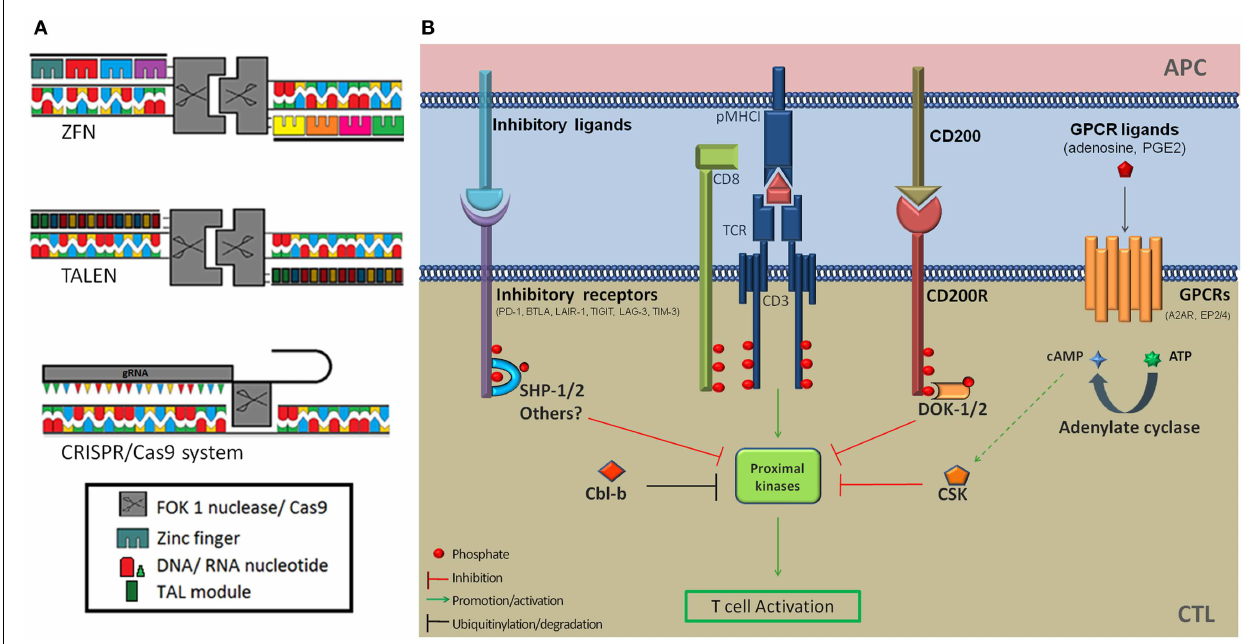
tyrosine residue of Src kinases and negatively regulatesTCR signaling. A2AR, adenosine A2a receptor; APC, antigen-presenting cell; BTLA-4, B- and T-lymphocyte attenuator; Cbl-b, casitas B-cell lymphoma; CTL, cytotoxic T-lymphocyte; DOK-1/2, docking protein 1/2; EP2/4, prostaglandin E receptor 2/4; Erk, extra-cellular signal regulated kinases; ITIM, immunoreceptor tyrosine-based inhibition motif; ITSM, immunoreceptor tyrosine-based switch motif; GPCR, G-protein coupled receptor; LAG-3, lymphocyte-activation gene 3; LAIR-1, leukocyte-associated immunoglobulin-like receptor 1; Lck, lymphocyte-specific protein tyrosine kinase; MHC1, major histocompatibility complex class 1; PD-1, programed death receptor 1; PD1-L1, programed death receptor 1-ligand 1; SHP-1, Src homology 2 domain containing protein tyrosine phosphatase;TCR,T-cell receptor;TIGIT,T-cell immunoreceptor with Ig and ITIM domains;TIM-3,T-cell immunoglobulin domain and mucin domain